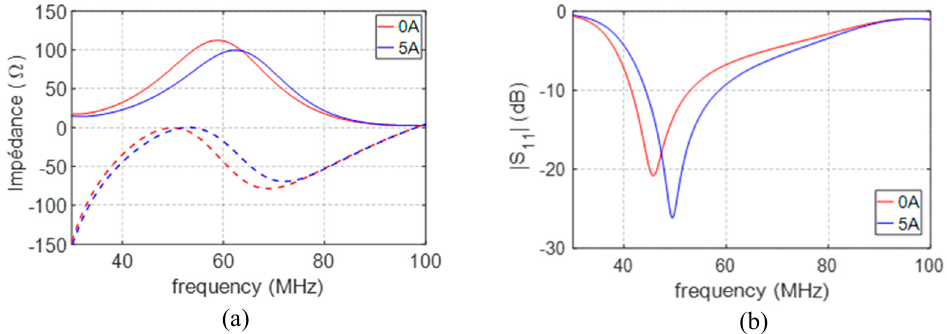
Figure 9. The antenna's frequency agility with a tuning current between 0A and 5A on ( a ) input impedance and ( b ) reflection coefficient .